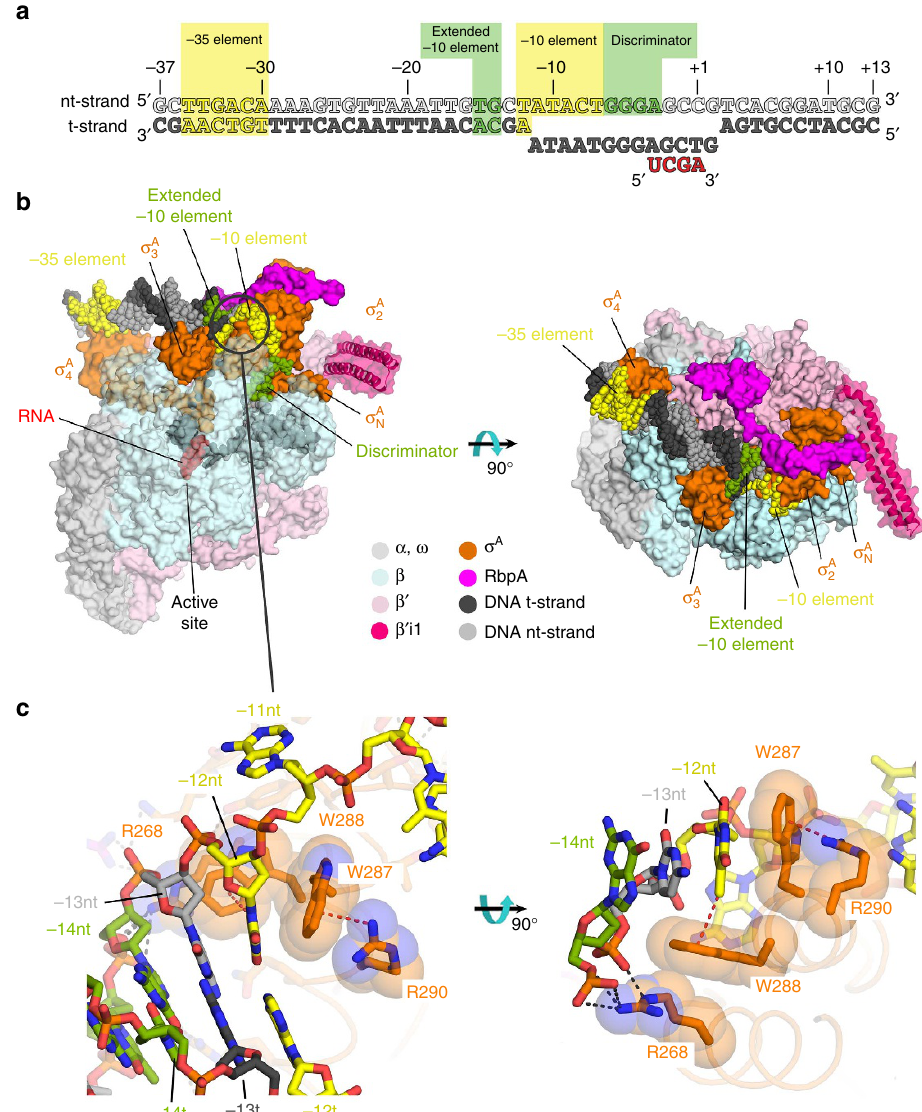
Figure 1 | Structure of the Msm RbpA/RPo. ( a ) Synthetic oligonucleotides used for the Msm RbpA/RPo crystallization. The numbers above denote the DNA position with respect to the RNA transcript 3 0 -end ( þ 1). The DNA sequence is derived from the full con promoter 63 . The nt-strand DNA (top strand) is coloured light grey; the t-strand DNA (bottom strand), dark grey; RNA, red. The (cid:2) 35 and (cid:2) 10 elements are shaded yellow. The extended (cid:2) 10 (ref. 38) and discriminator 64,65 elements are coloured green. ( b ) Overall structure of the Msm RbpA/RPo. The color-coding of most of the structural features is denoted in the legend. Protein components (core RNAP, s A , RbpA) are shown as molecular surfaces. The surface of the RNAP b subunit is transparent, revealing the nucleic acids and s A elements located in the RNAP active centre cleft. The surface of the lineage-specific insert b 0 i1 is transparent, revealing the a -carbon backbone ribbon underneath. The nucleic acids are shown as CPK atoms, coloured as in Fig. 1a. The circled region in the left view is magnified in Fig. 1c. ( c ) Magnified views showing the upstream ds/ss junction of the transcription bubble in RPo (obscuring elements of the structure have been removed). Side chains of the absolutely conserved s A W-dyad (W288/W287) and conserved s A Arg residues that buttress the W-dyad (R268, R290) are shown in orange along with transparent CPK spheres (Supplementary Fig. 2D). Polar interactions (hydrogen bonds, salt bridges) are shown as grey dashed lines. The cation- p interaction 19 (R290-W287) and the methyl- p interaction 17,18 [T (cid:2) 12 (nt)-W288] are shown as red dashed